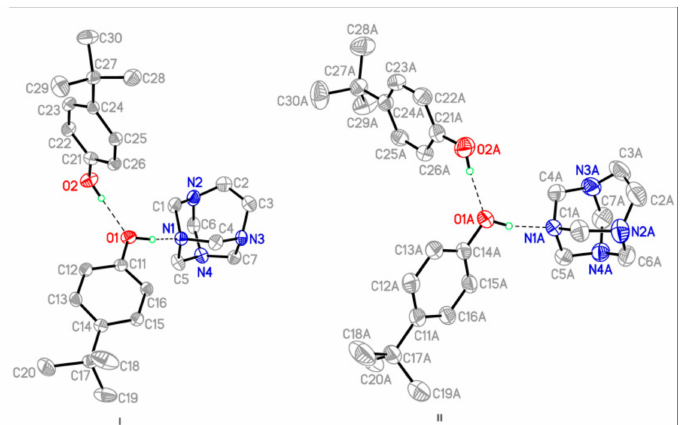
Figure 1. A view of the two independent three-molecule aggregate (I and II) in the asymmetric unit of the title compound with the atom-labelling scheme and 50% probability displacement ellipsoids, showing the O–H ··· N and O–H ··· O hydrogen bond interactions as purple dashed